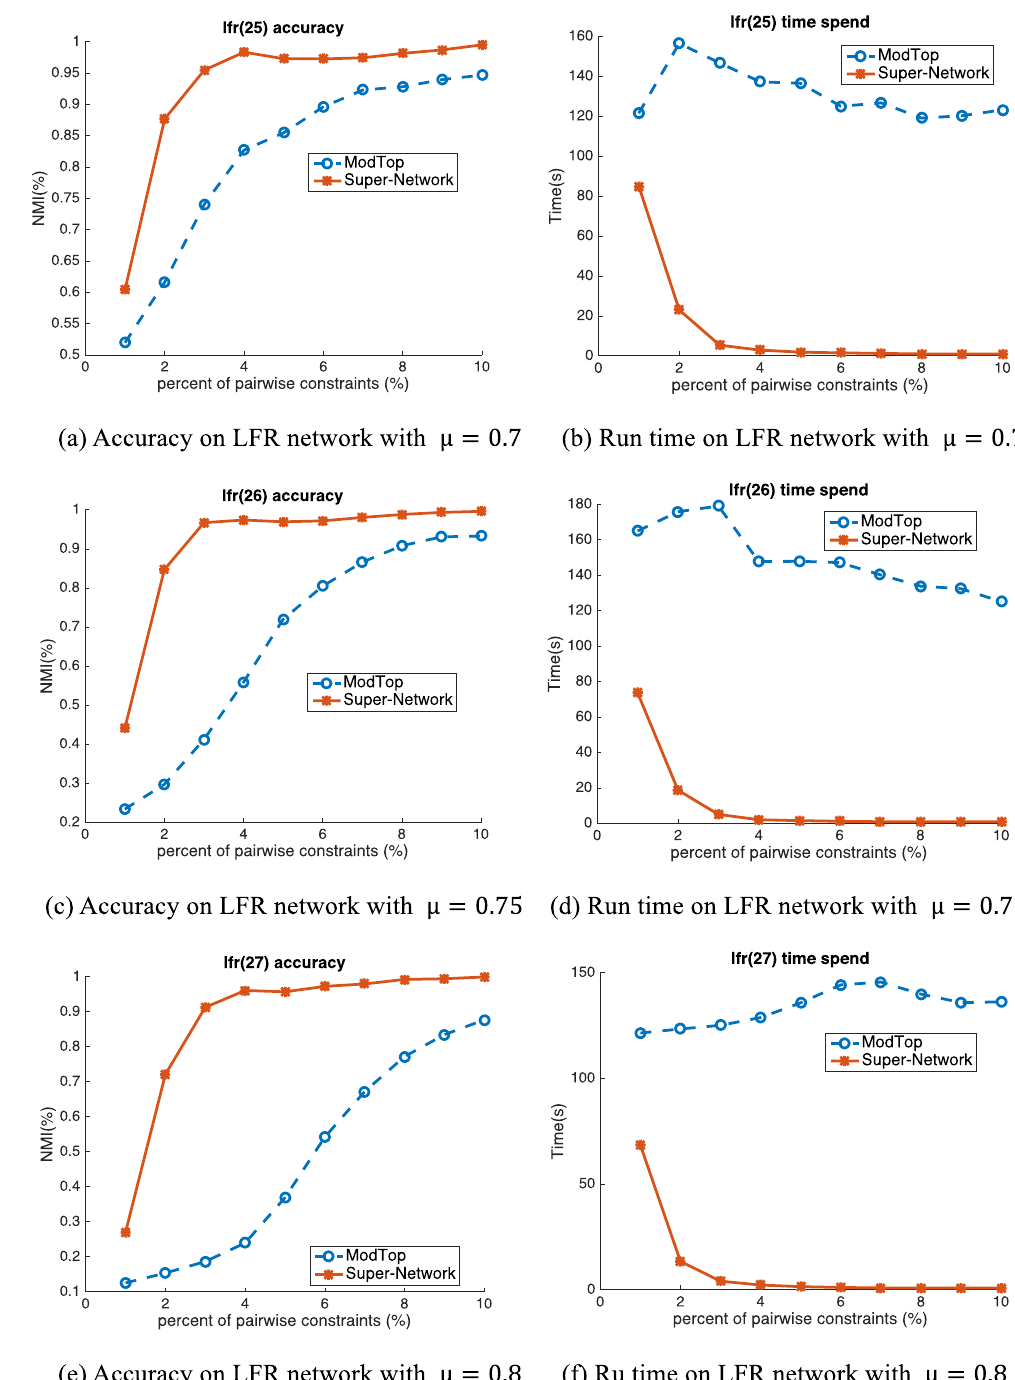
Figure 4. Accuracy (NMI) and run time (spent time in second) on LFR benchmark networks based on